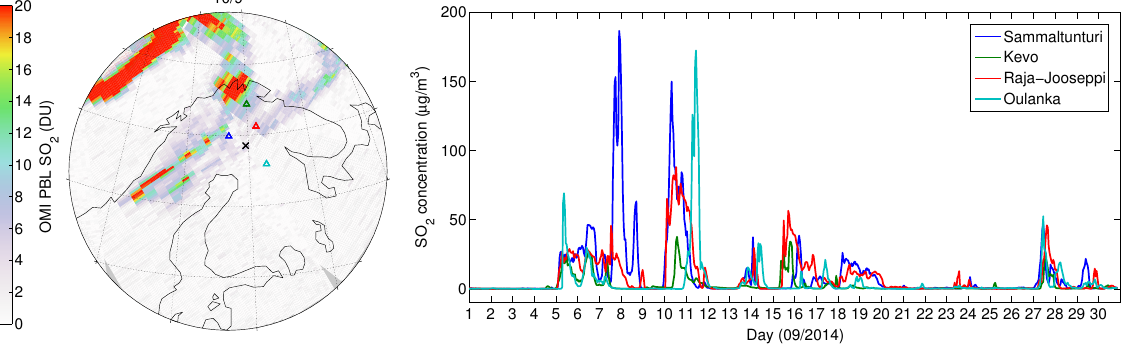
Figure 3. Left panel: OMI SP PBL (PCA algorithm) during 10 September 2014. The black cross indicates the location of Sodankylä. The triangles indicate the location of the air quality stations: Sammaltunturi (blue), Kevo (green), Raja-Jooseppi (red), Oulanka (light blue). Right panel: Time series of the SO 2 concentration in the northern Finland air quality stations in September